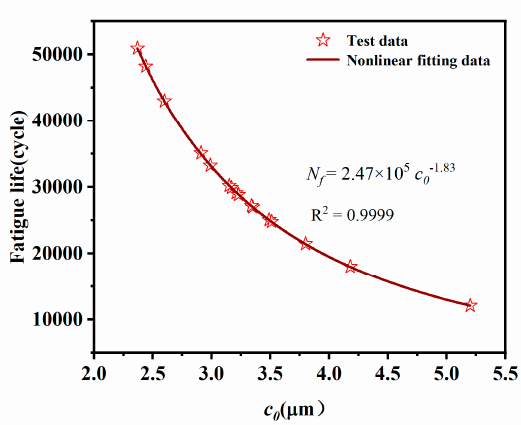
Figure 13. Fitting curve of fatigue life and crack precursor size.